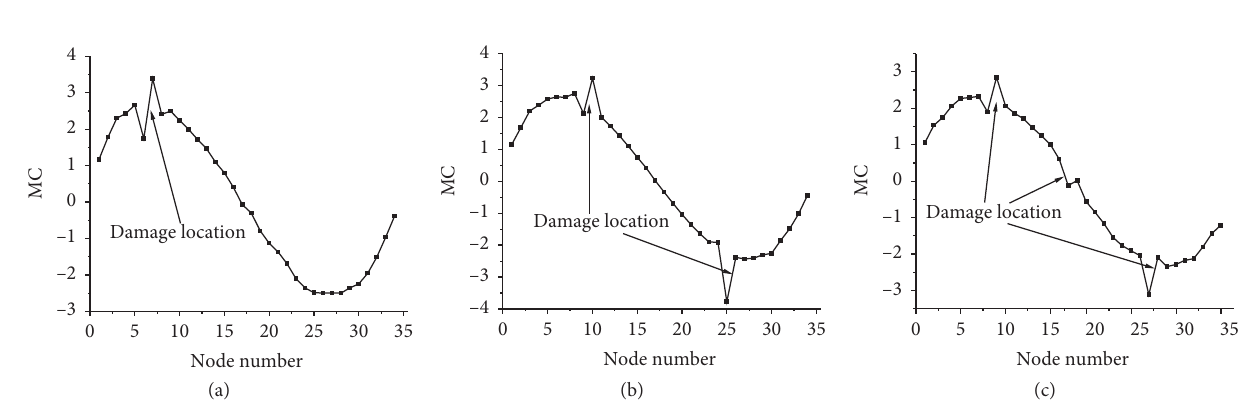
Figure 24: Damage identification result of MC. (a) Case 6. (b) Case 7. (c) Case